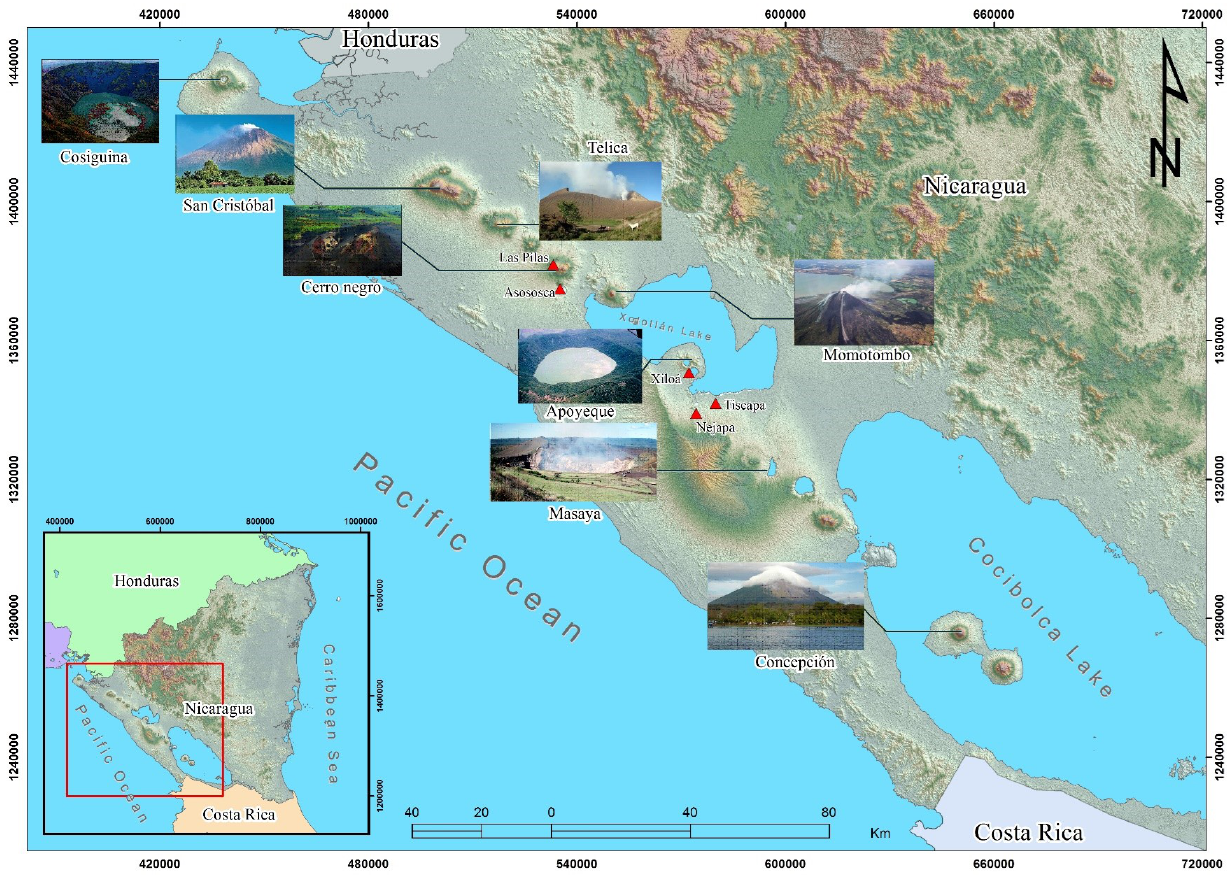
Figure 1: Active volcanic structures monitored by the Volcanology Directorate, INETER. Coordinate system WGS84. Red triangles indicate unmonitored active